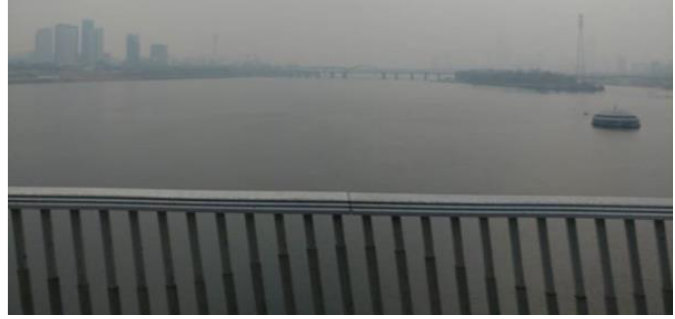
Figure 2. Example of the rolling shutter effect (RSE).